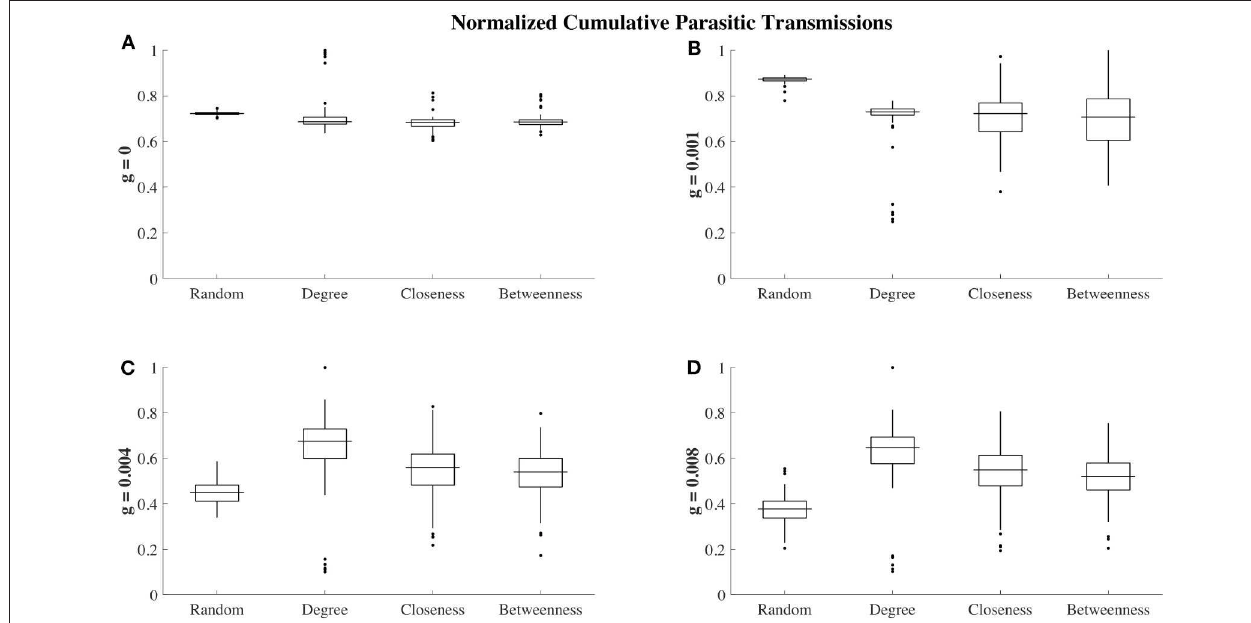
FIGURE 6 | Cumulative number of ectoparasite transmissions over t = 300 steps (150 time-steps after ectoparasite introduction) for different grooming efficiencies and social affiliation strategies. Each box plot shows cumulative transmissions over 100 trials, where transmissions have been re-scaled between 0 (no transmissions occurred) and 1 (maximum number of transmissions observed for a given grooming efficiency). In the absence of grooming ( g = 0, A ), all 4 of the social affiliation strategies result in similar transmission levels in all trials, although there are outlier trials with large numbers of transmissions with the degree affiliation strategy. For low grooming efficiencies ( g = 0.001, B ), the most transmissions are instead observed for the random affiliation strategy. When grooming efficiency is increased to g = 0.004 (C) , the random affiliation strategy then shows the fewest median number of transmissions, followed by closeness and betweenness. The degree affiliation strategy has the highest median number of transmissions, although there is a large spread and in some trials there are a very low number of transmissions. We also observe this qualitative behavior when g = 0.008 (D)